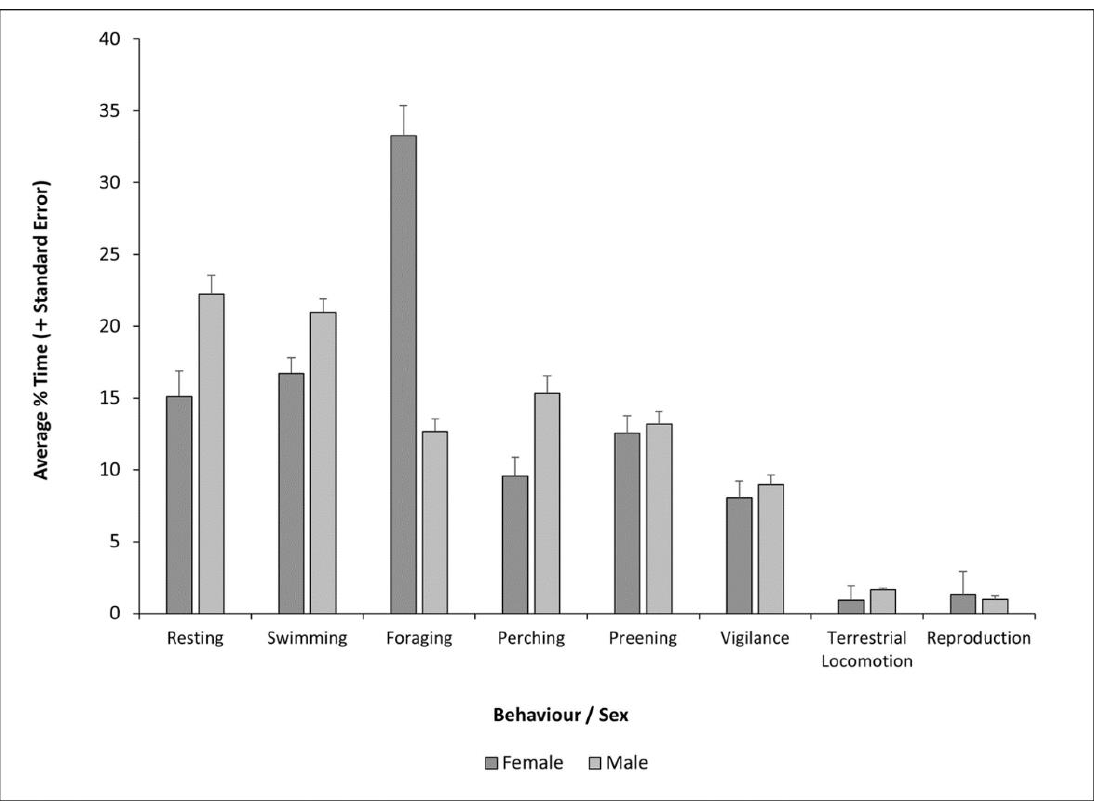
Figure 4. Average percentage time budget (showing positive SE bars) of the female and male Man-